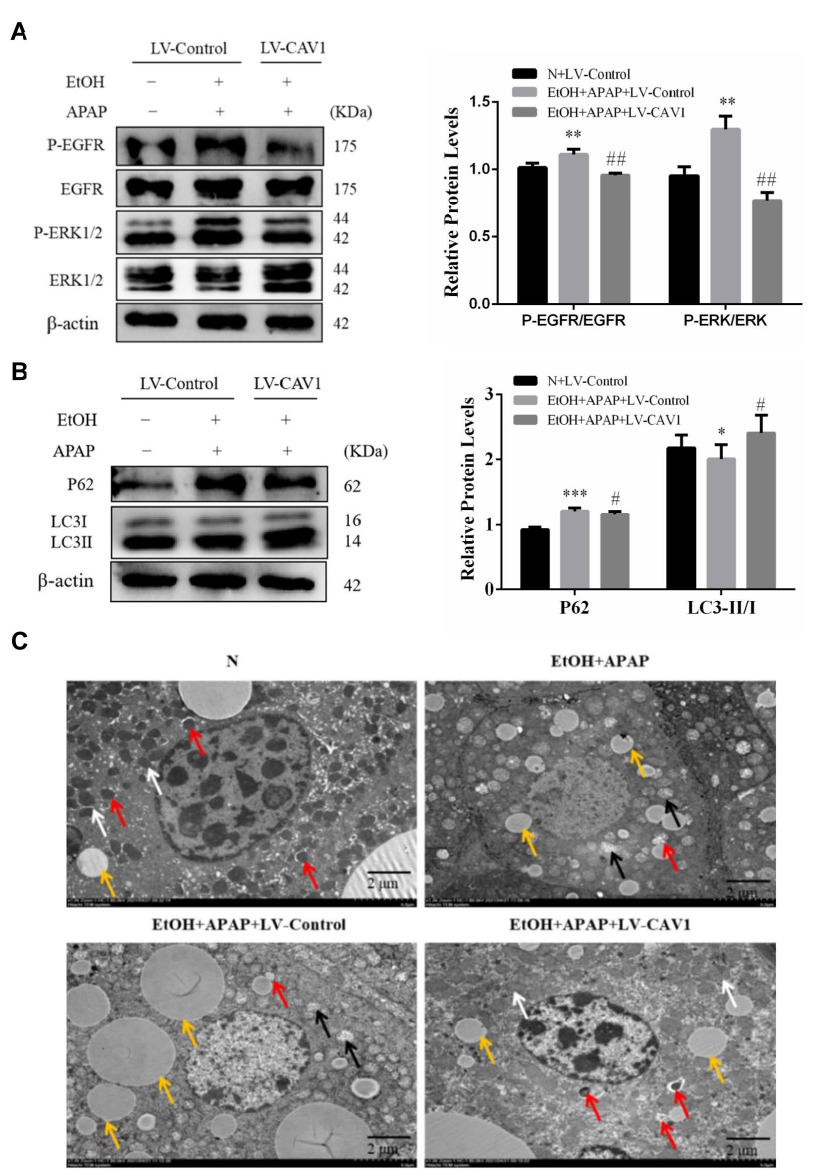
Figure 4. CAV1 alleviates APAP-induced lipid accumulation in AFLD by affecting the Ang II/EGFR/ERK axis and restoring autophagic flux. ( A ) Western blot analysis of p-EGFR/EGFR and p-ERK/ERK protein levels. ( B ) Western blot analysis of P62 and LC3 II / I protein levels. ( C ) Transmission electron microscopy analysis of mitochondria, autophagosomes and lipid droplets in liver tissues. White arrows show normal mitochondria, yellow arrows show damaged mitochondria, black arrows show lipid droplets and red arrows show autophagosomes. The number of autophagosomes per given area (mean ± S.D.) was determined (Scale bar = 5.0 μm). Data represent the mean ± SEM (n = 8 mice). * p < 0.05 vs. N + LV-Control group; ** p < 0.01 vs. N + LV-Control group; *** p < 0.001 vs. N + LV-Control group; # p < 0.05 and ## p < 0.01 vs. EtOH + APAP + LV-Control group.